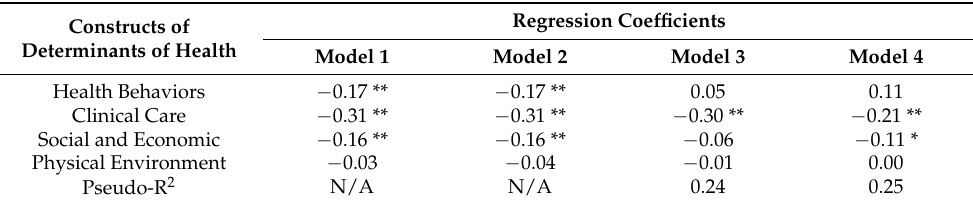
Table 2. Associations between constructs of determinants of health and the gap in non-adherence to antihypertensive medications between Black/African Americans and non-Hispanic